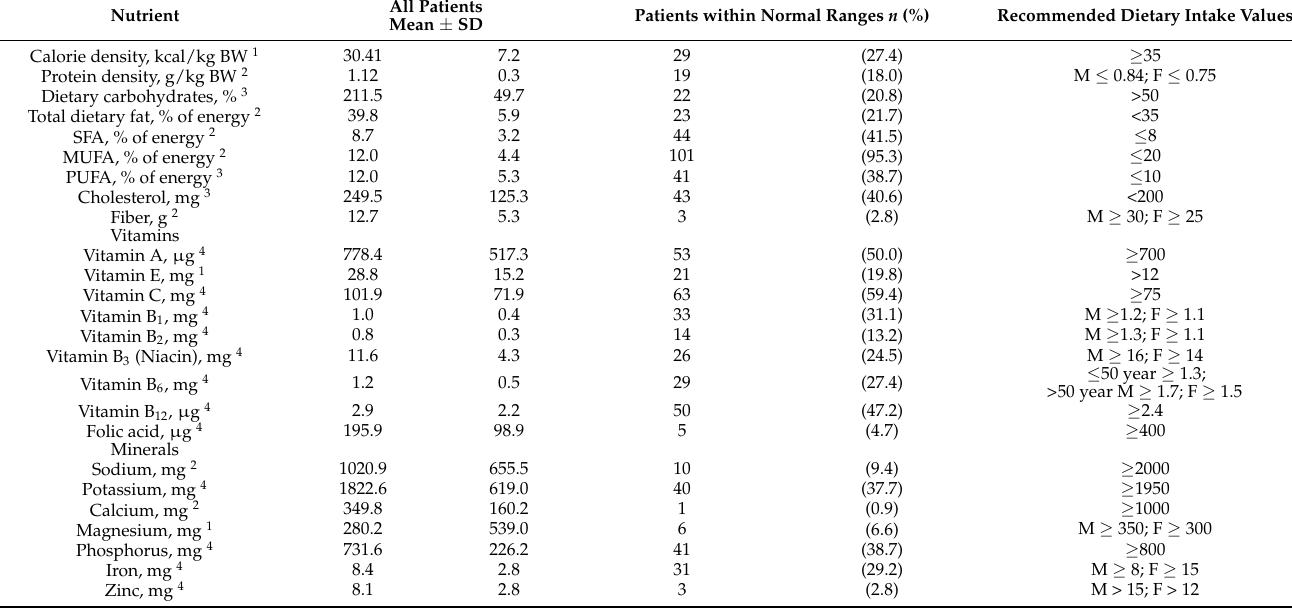
Table 2. Dietary nutrient intake and the proportions of individuals within recommended target ranges ( n = 106). Nutrient All Patients Mean ± SD Patients within Normal Ranges n (%) Recommended Dietary Intake Values Calorie density, kcal/kg BW